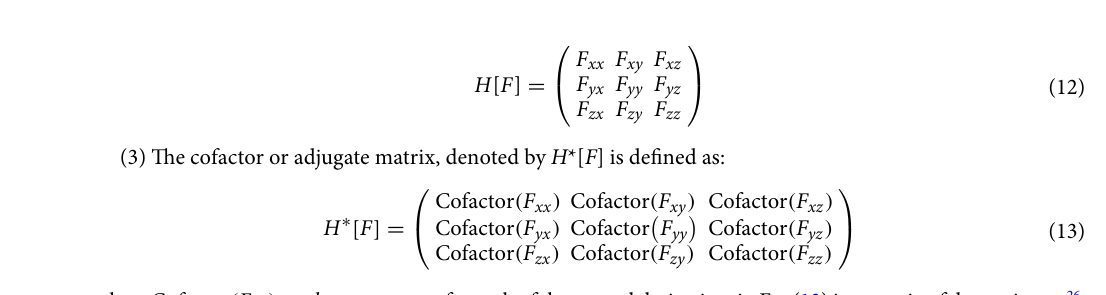
Figure 2. Data from the mesh in Fig. 1 showing the length-distribution histogram of edges in 20 bins (green); and, 200 bins (red inset). The mean edge length overall was 62 nm. The median bin (tallest green pillar) contained 38% of the total bin contents and spanned 60–65 nm; while the two most abundant bins spanning 60–70 nm contained 75% of the edge lengths. Notebook 2 has the Mathematica script used to generate this